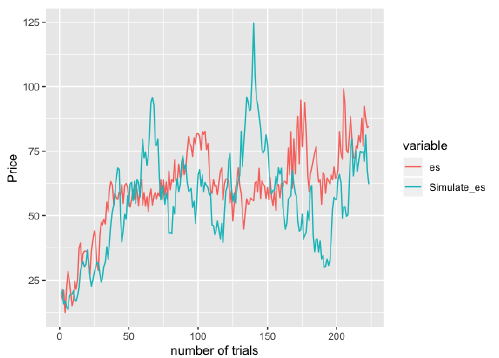
Figure 8. Simulation Result of IGBM model on energy-switching data.